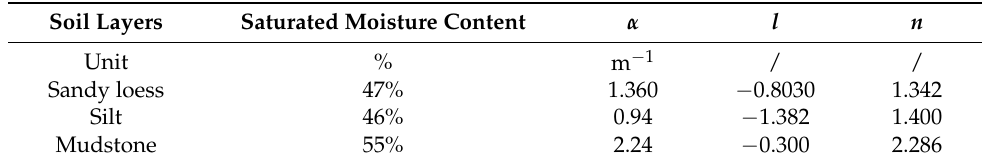
Table 3. Parameters for Van Genuchten function of the three soils.